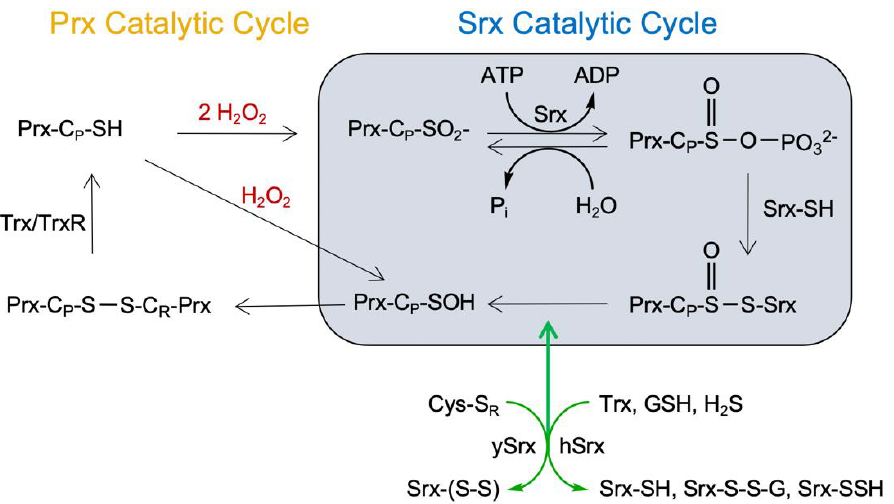
Figure 1. Peroxiredoxin catalytic and sulfiredoxin repair cycles. The resolution of the Prx-Srx complex involves the reduction of the thiosulfiate intermediate (Prx-C P -S=O-S-Srx) to yield the Prx Cys-sulfenic acid intermediate (Prx-C P -SOH). Yeast Srx contains an adjacent resolving Cys residue (Cys-S R ) that can react with the thiosulfinate intermediate leading to the formation of an Srx intra- molecular disulfide (Srx-(S-S)). In contrast, human Srx has only one Cys residue and requires an exogenous reductant. Possible reductants include the Trx system (Trx/TrxR/NADPH), glutathione (GSH) and hydrogen sulfide (H 2 S); these reductants would ultimately yield reduced Srx (Srx-SH).